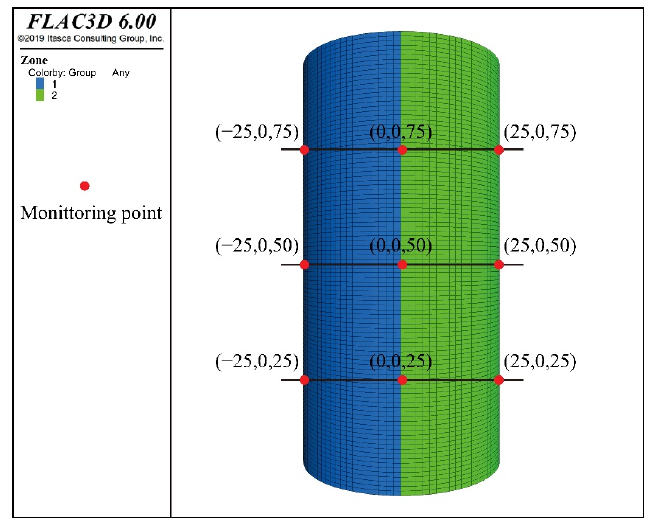
Figure 15. Model and distribution map of monitoring points.